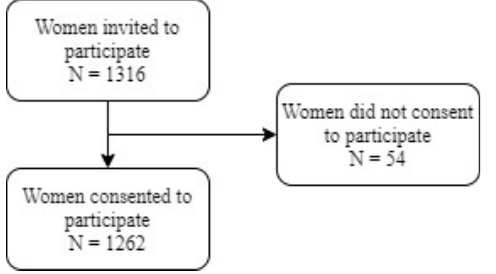
Figure 1. Recruitment of participants.